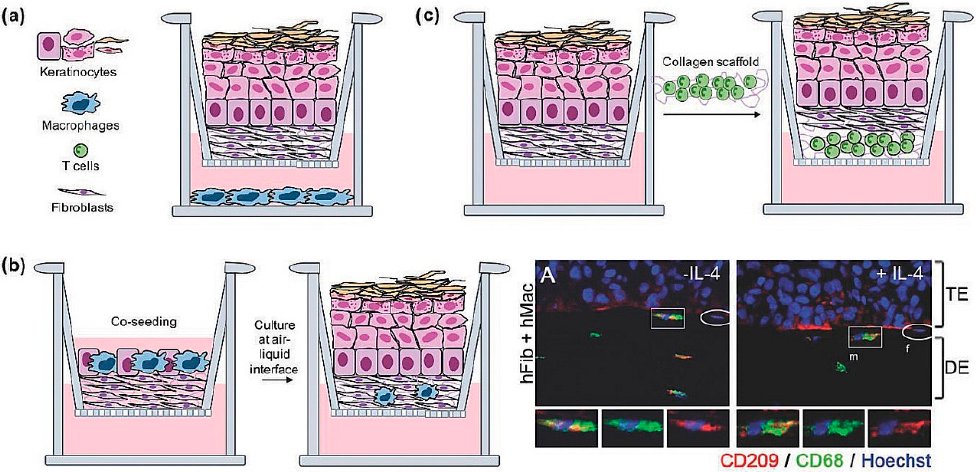
Figure 5. Skin inflammation on chip: ( A ) Representation of an inflamed skin-on-chip configuration composed of a three-layers PDMS device and two PET porous membranes. Each layer corresponds to a cell line comprising human skin and, in particular, from bottom to top, endothelial cells, fibroblasts, and keratinocytes. Reproduced under the terms of the CC BY 4.0 license from Wufuer M, Lee GH, Hur W, et al. Skin-on-a-chip model simulating inflammation, edema and drug-based treatment. Sci Rep 2016; 6:1–12. [74] Copyright © 2016, The Author(s); published by Springer Nature. ( B ) Simulation of inflammation triggered by a wound through a microfluidic device. The microfluidic chip consists of three layers that host the cells that directly participate in this physiological process. Fibroblasts and macrophages are fluxed through the lateral channels while, in the central one, is added a Matrigel, which reproduces ECM, together with endothelial cells. Reprinted from Biglari S, Le TYL, Tan RP et al. Simulating Inflammation in a Wound Microenvironment Using a Dermal Wound-on-a-Chip Model. Adv Healthc Mater 2019; 8:1801307 [70] with permission from John Wiley and Sons.